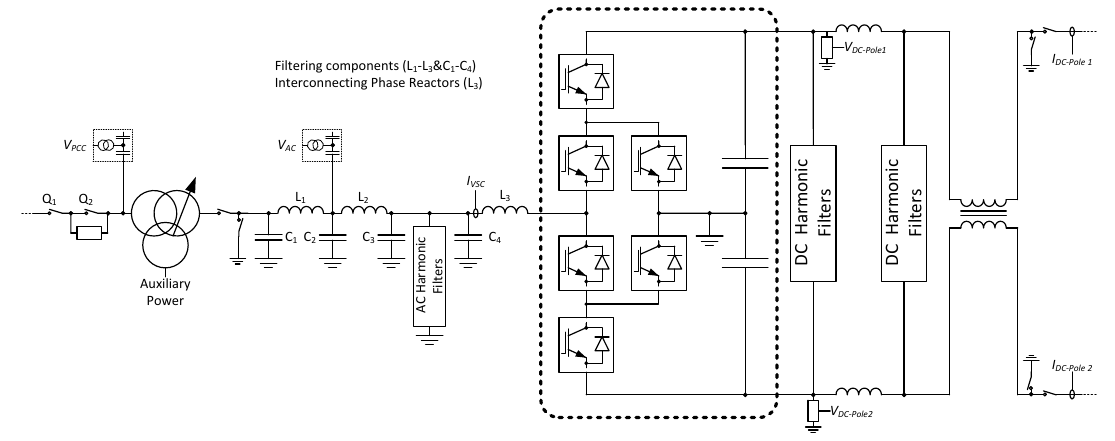
Figure 28. MurrayLink VSC HVDC Converter Station.